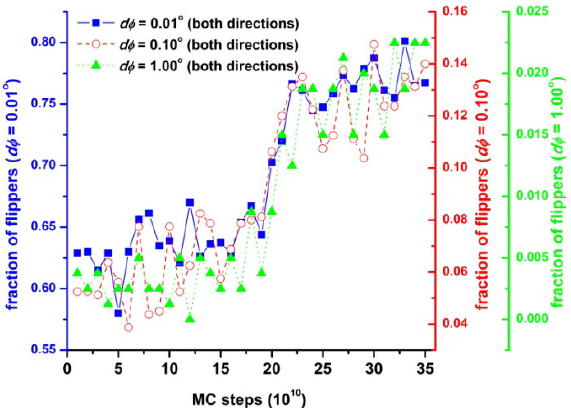
Figure 14. Fraction of sites (flippers), which can perform a flip-like move clockwise and counter-clockwise of amplitudes d ϕ = 0.01, 0.10 and 1.00° as a function of MC steps from simulations on the N = 12 chain system with uniform chain length distribution at φ = 0.61. Reproduced from [98] with permission from The Royal Society of Chemistry.